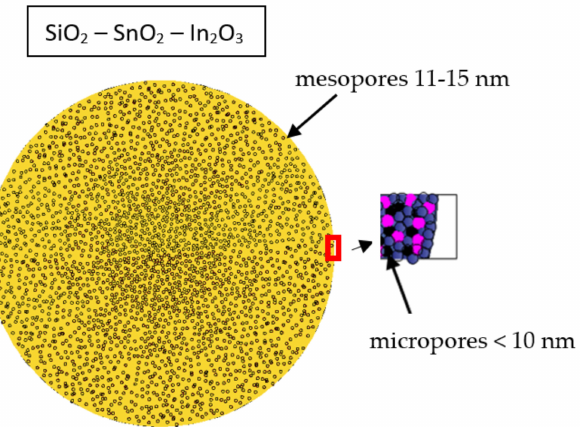
Figure 21. Hierarchical model of the formation of three-component porous